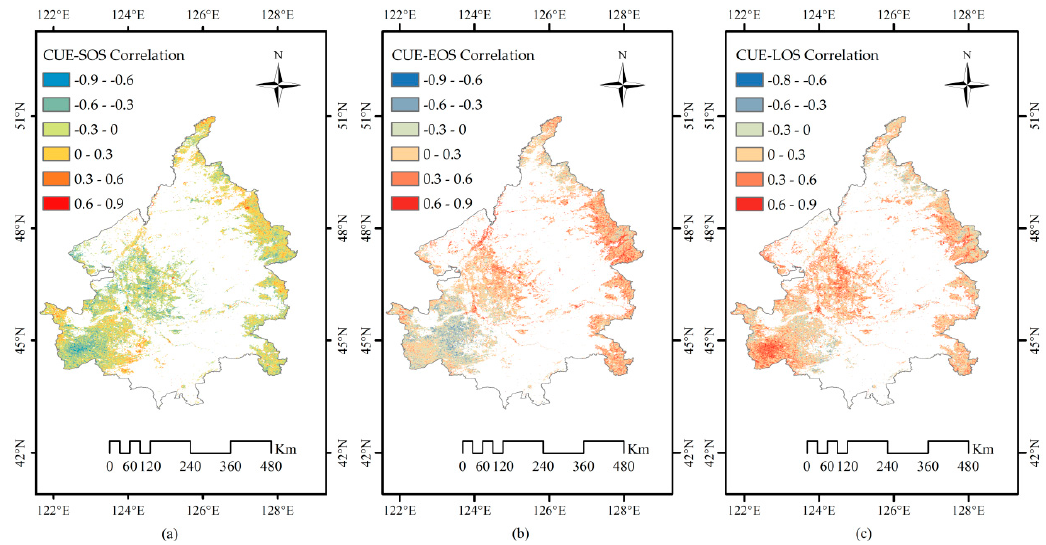
Figure 10. Spatial distribution of correlation coefficients (R) between CUE, SOS, EOS and LOS in the SNP during 2001–2015. ( a ) CUE and SOS; ( b ) CUE and EOS; ( c ) CUE and LOS.